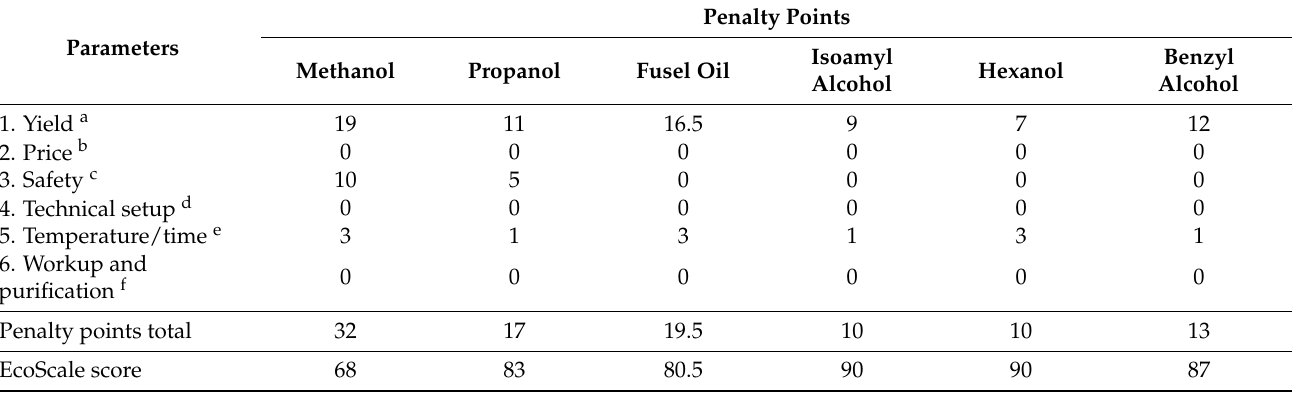
Table 4. EcoScale score for the enzymatic production of several octanoate esters catalyzed by immo- bilized lipase Eversa ® Transform